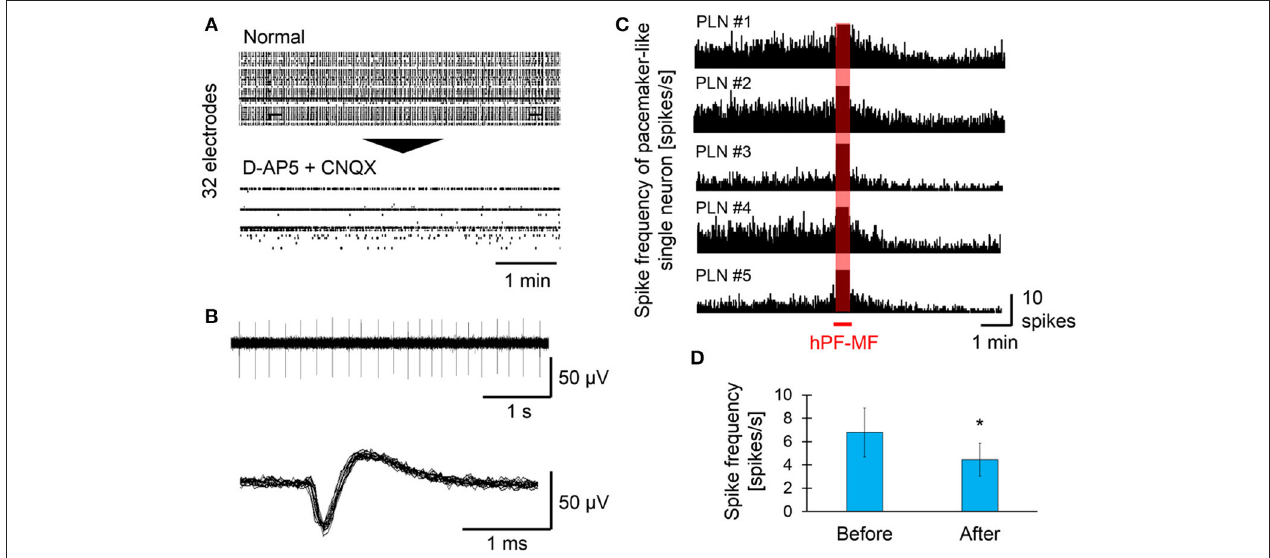
FIGURE 6 | Effect of hPF-MF exposure on the autonomous activity of pacemaker-like neurons. (A) Screening of autonomous activity using MEAs and the pharmacological method. Even after D-AP5 and CNQX application, autonomous activity was detected in a few electrodes. (B) Detection of single pacemaker-like neuronal activity. Spontaneous activity with a frequency of 4–10Hz, which is found in inhibitory neurons, was selected in some electrodes, then the effects of hPF-MF exposure on autonomous activity were evaluated. (C) Evaluation of the spike frequency after 400 mT hPF-MF exposure on the various pacemaker-like neurons. All autonomous activity detected from different cultures was reduced after 400 mT hPF-MF exposure. (D) Comparison of spike frequency before and after 400 mT hPF-MF exposure. N = 6 independent pacemaker-like neurons, ± SD, * P <